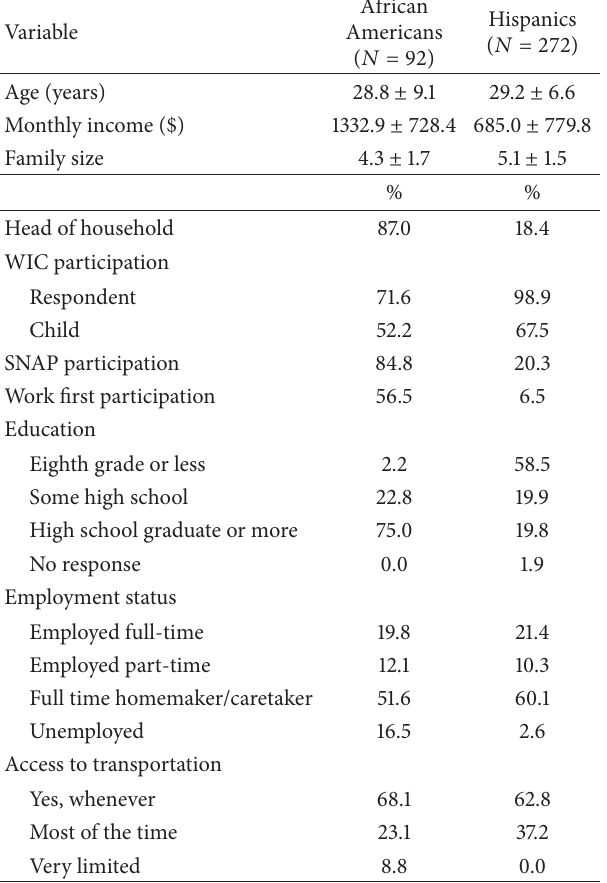
Table 2: Demographic characteristics of African American and Hispanic women.